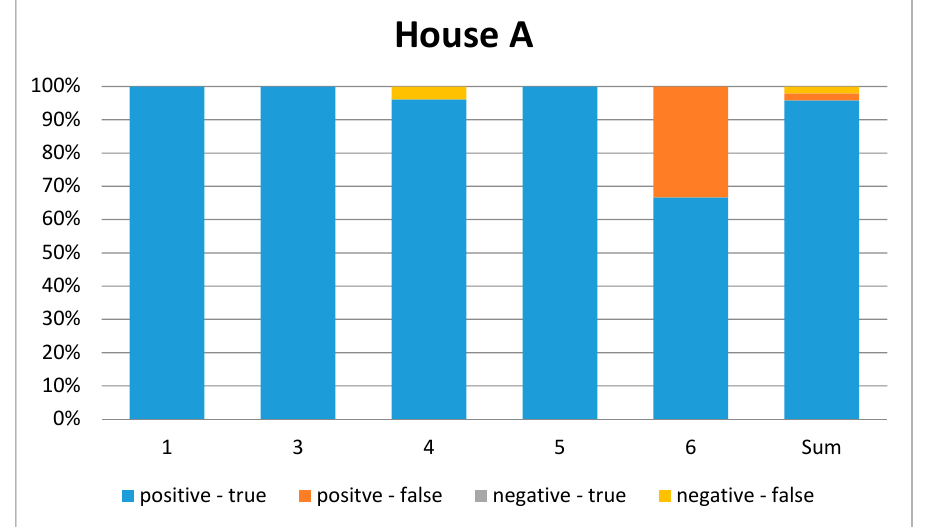
Figure 7. Graphical representation of the confusion matrix for House A. Each bar represents one ADL. (1 = leave house, 3 = eating, 4 = toilet usage, 5 = shower, 6 = brush teeth). The last bar represents the overall ADL.